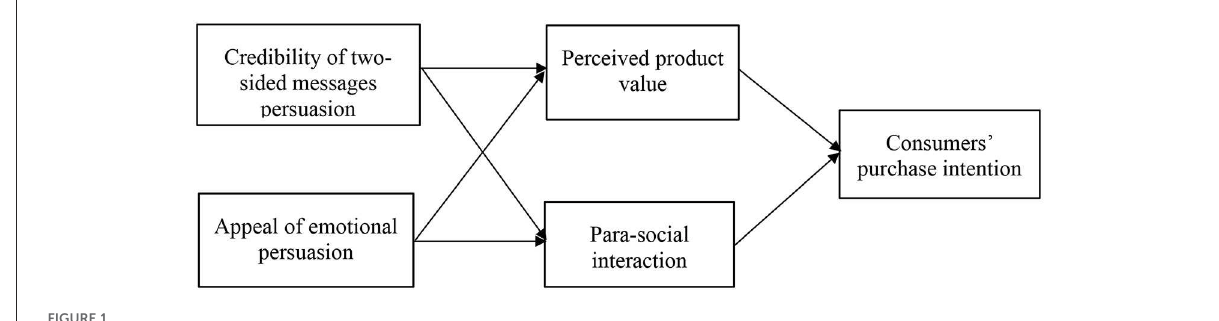
FIGURE1 Theoretical model.